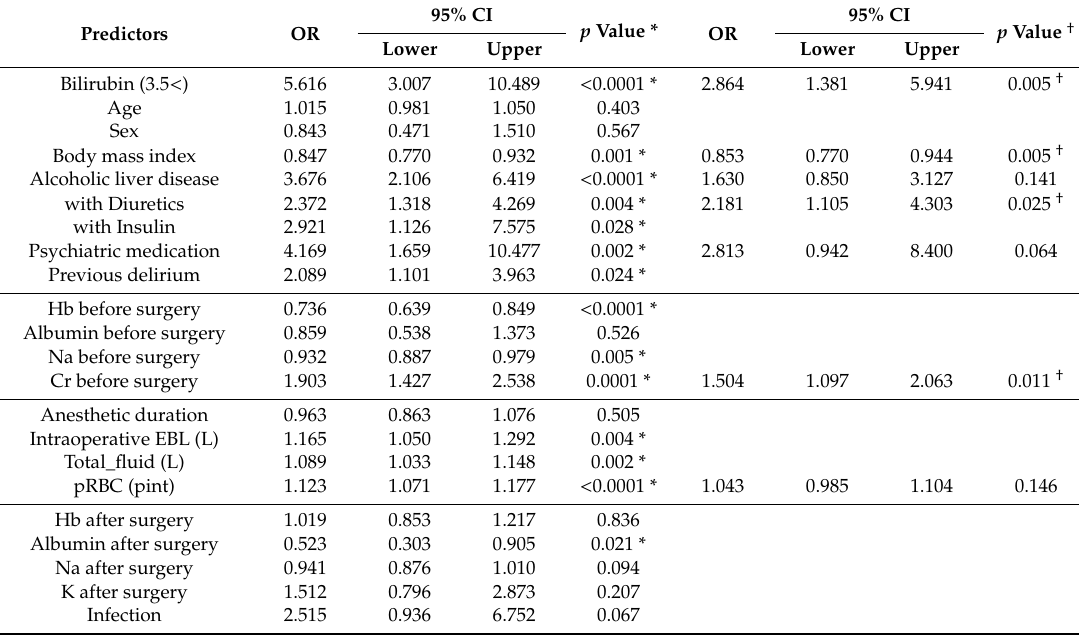
Table 5. Logistic regression analysis.